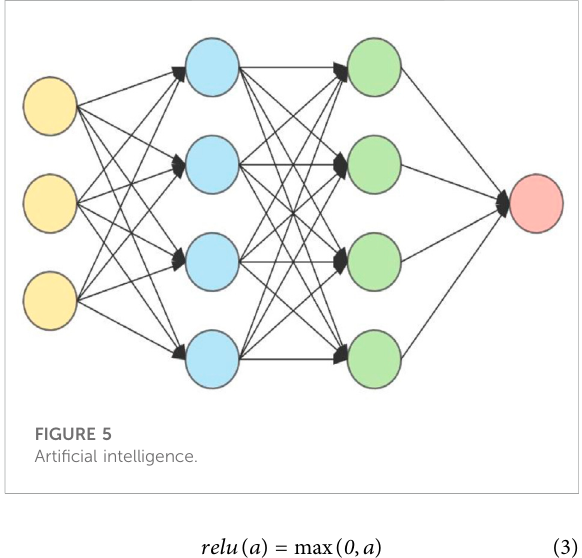
FIGURE 5 Arti fi cial intelligence.